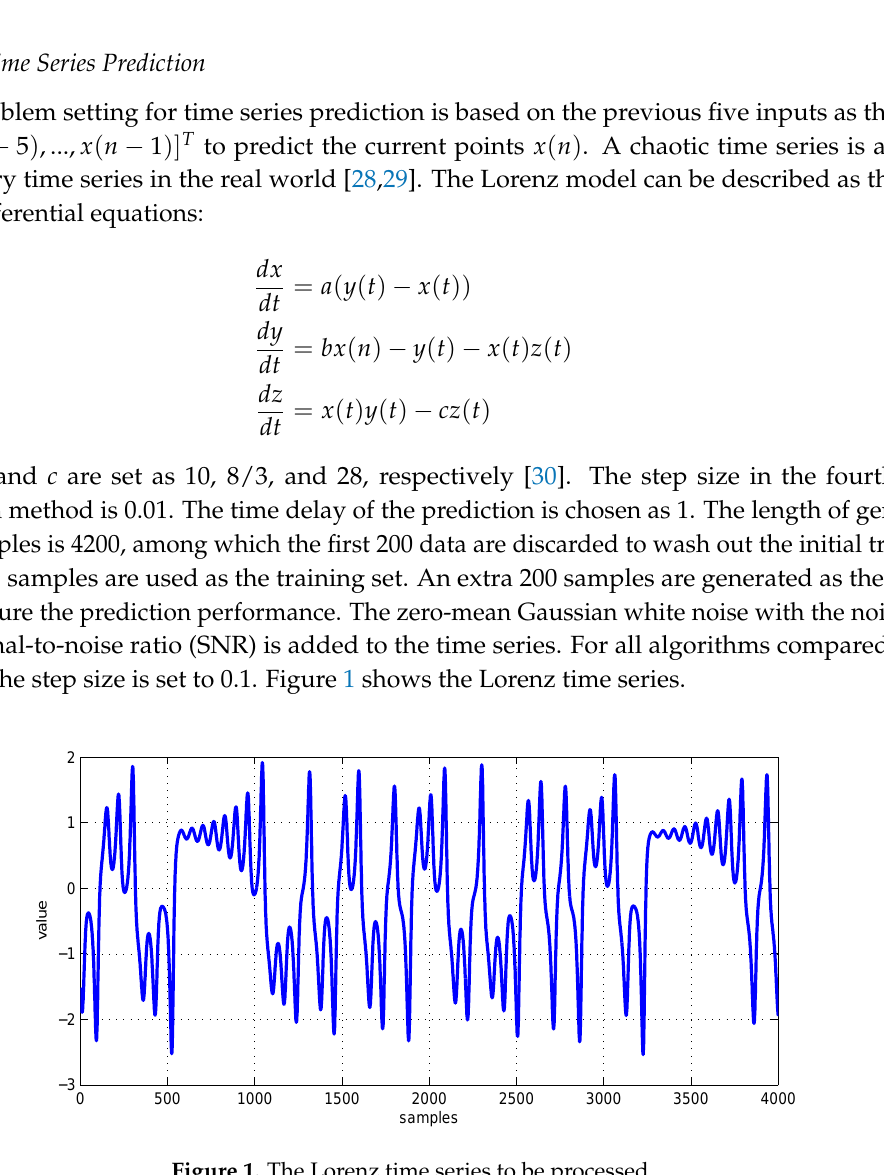
Figure 1. The Lorenz time series to be